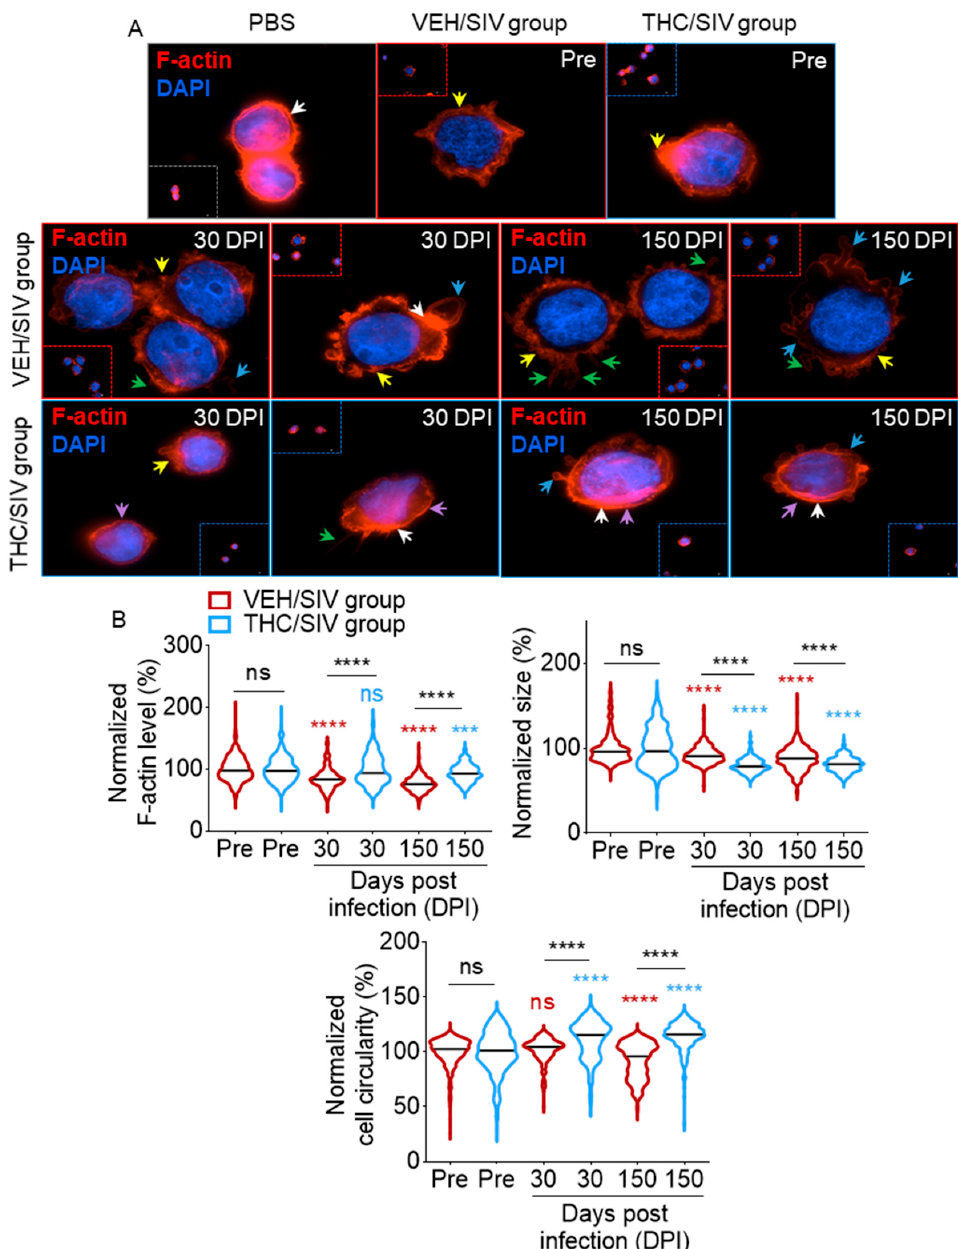
Figure 6. THC / SIV BEVs dampen SIV-induced changes in cytoskeletal organization: ( A ) F-actin (red) Figure 6. THC/SIV BEVs dampen SIV ‐ induced changes in cytoskeletal organization: ( A ) F ‐ actin (red) and and DAPI (blue) staining of U937 cells incubated with 1000 µ g / mL BEVs for 18 h. Fluorescence DAPI (blue) staining of U937 cells incubated with 1000 μ g/mL BEVs for 18 h. Fluorescence images were images were manually obtained at 60 × magnification using the Lionheart FX automated microscope. manually obtained at 60× magnification using the Lionheart FX automated microscope. Yellow arrows Yellow arrows depict membrane ru ffl ing, white arrows depict areas of increased F-actin localization, depict membrane ruffling, white arrows depict areas of increased F ‐ actin localization, green arrows depict green arrows depict filopodia-like protrusions, blue arrows depict lamellipodia-like protrusions, filopodia ‐ like protrusions, blue arrows depict lamellipodia ‐ like protrusions, and purple arrows depict and purple arrows depict smooth prominent cortical shell. ( B ) Quantification of single-cell F-actin smooth prominent cortical shell. ( B ) Quantification of single ‐ cell F ‐ actin fluorescence intensity (top left fluorescence intensity (top left panel), cell size (top right panel), and cell circularity (bottom panel). panel), cell size (top right panel), and cell circularity (bottom panel). Five 10× magnification fields of view Five 10 × magnification fields of view were analyzed per time point. Ordinary one-way ANOVA were analyzed per time point. Ordinary one ‐ way ANOVA (Brown–Forsythe and Bartlett tests, with Sidak’s (Brown–Forsythe and Bartlett tests, with Sidak’s multiple comparisons test) was used to determine multiple comparisons test) was used to determine the statistical significance within the group. Binary the statistical significance within the group. Binary Student’s t tests (Welch’s correction) were used to Student’s t tests (Welch’s correction) were used to determine significant differences between groups for determine significant di ff erences between groups for each of the time points in each group. *** p < 0.005, each of the time points in each group. *** p < 0.005, **** p < 0.001, and ns = non ‐ significant. **** p < 0.001, and ns =